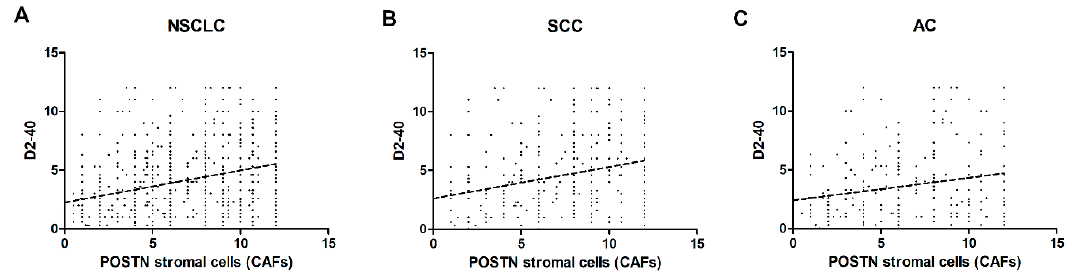
Figure 7. Correlations of periostin (POSTN) expression levels in stromal cells (CAFs) with podoplanin (D2-40) in ( A ) non-small cell lung carcinoma (NSCLC) ( r = 0.27, *** p < 0.001), ( B ) squamous cell cancer (SCC) ( r = 0.25, *** p < 0.001), and ( C ) adenocarcinoma (AC), ( r = 0.20, *** p < 0.001).